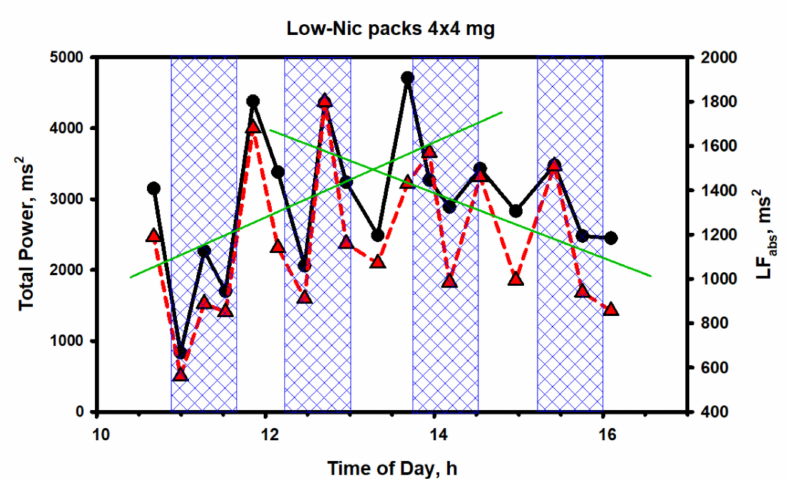
Figure 13. Dynamics of the HRV indicators during testing of the series of 4 nicotine packs (4 mg of nicotine each). The solid black line is the dynamics of the total spectrum power (TP), the red dotted line refers to the dynamics of the low-frequency spectrum component (LFabs) and the green lines are the averaged trend lines of both indicators at the two time intervals (in the first and the second halves of the test